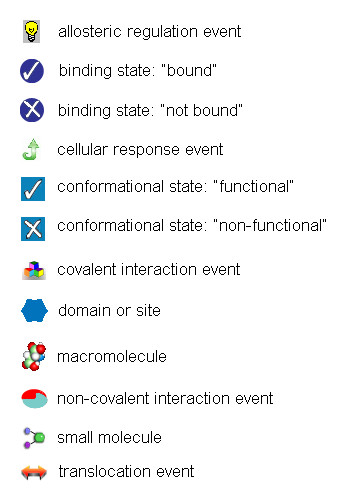
Description of icons used in other figures.